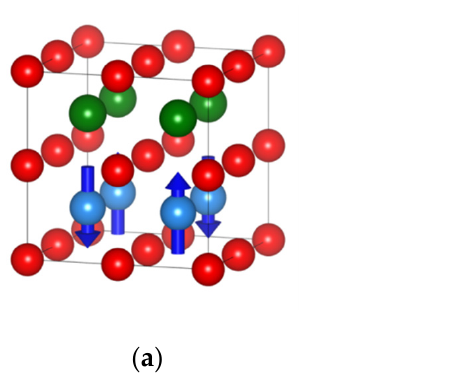
Figure 1. Schematic crystal and spin structures of the pseudo- B 2-( a ) I and ( b )-II phases for Ni 2 MnAl. Red, blue and green atoms represent Ni, Mn and Al, respectively.